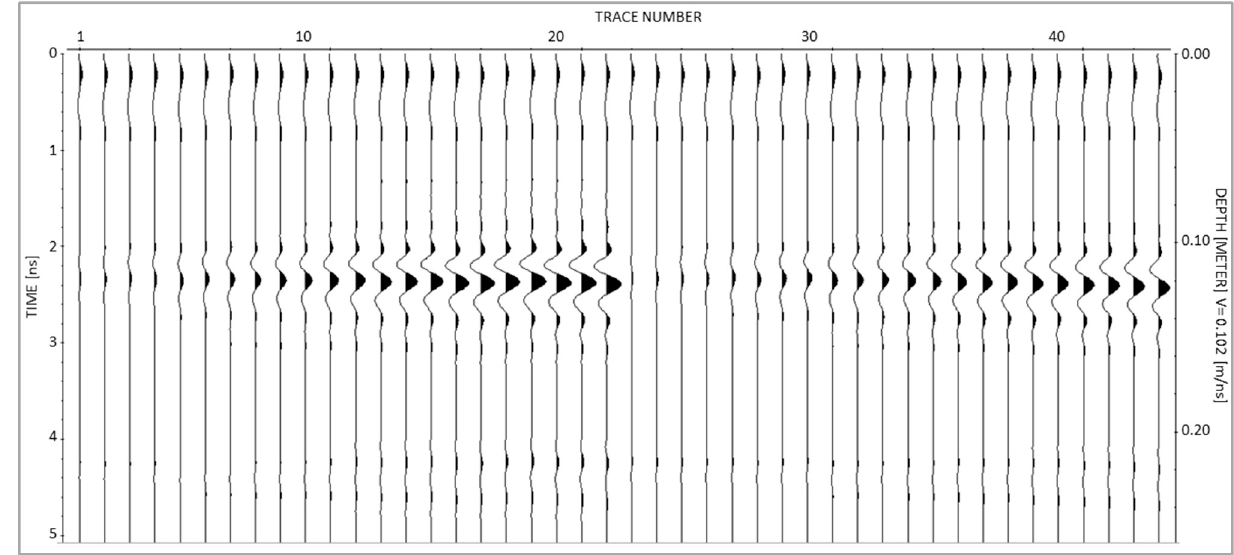
Figure 6. Data processing results for measurements on the air-filled and PVC-filled fractures with the thickness value varying from 0.25 mm to 16 mm (see Table 1). Note that the horizontal axis is the stacked trace number: 1–22 for the air-filled fractures and 23–44 for the PVC-filled fractures.